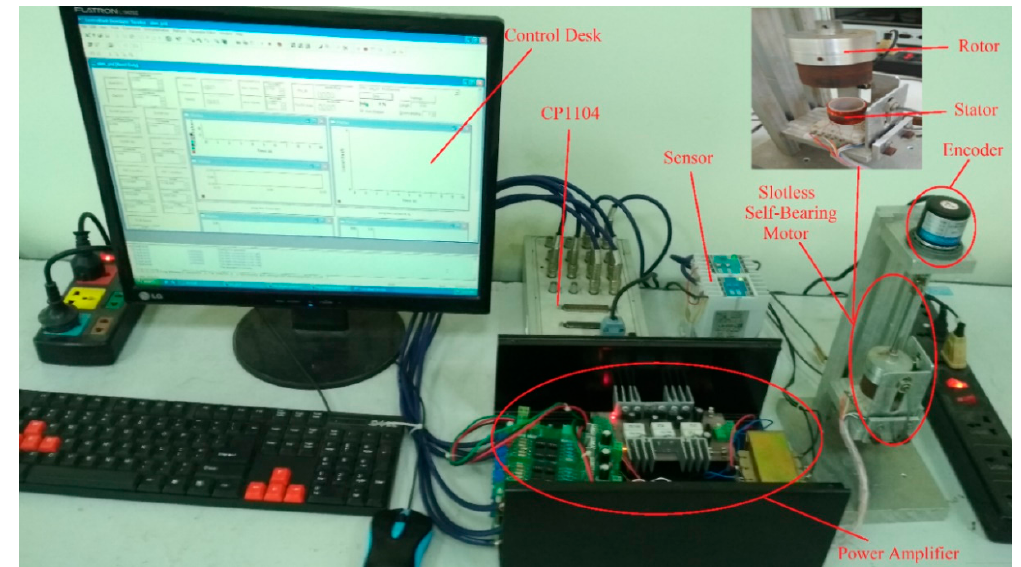
Figure 13. Experimental system.